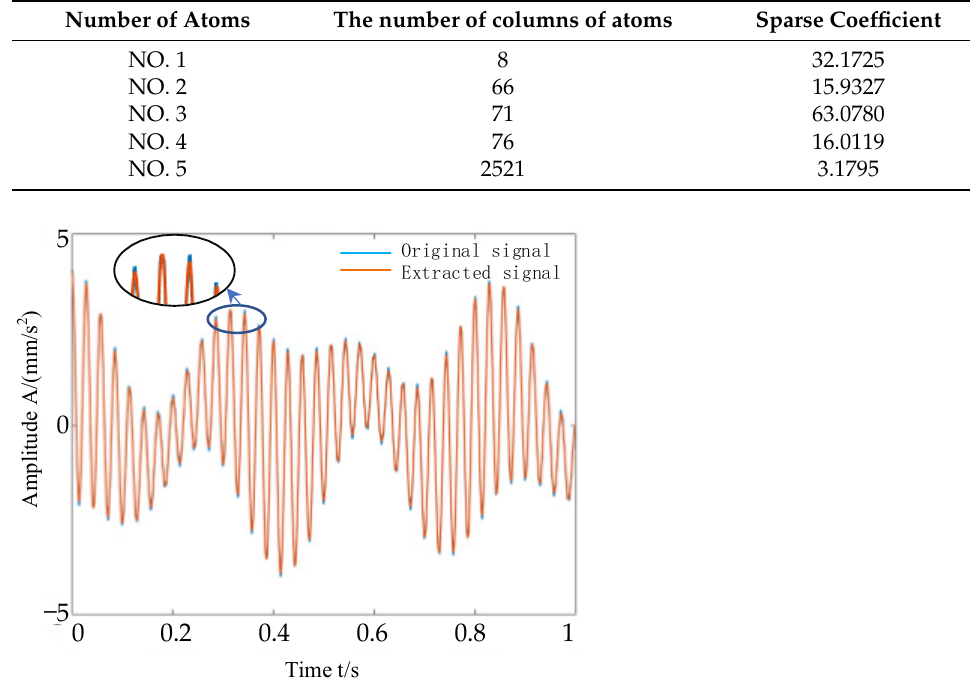
Figure 4. Comparison of harmonic components extracted by adapOMP algorithm and original har- monic components.